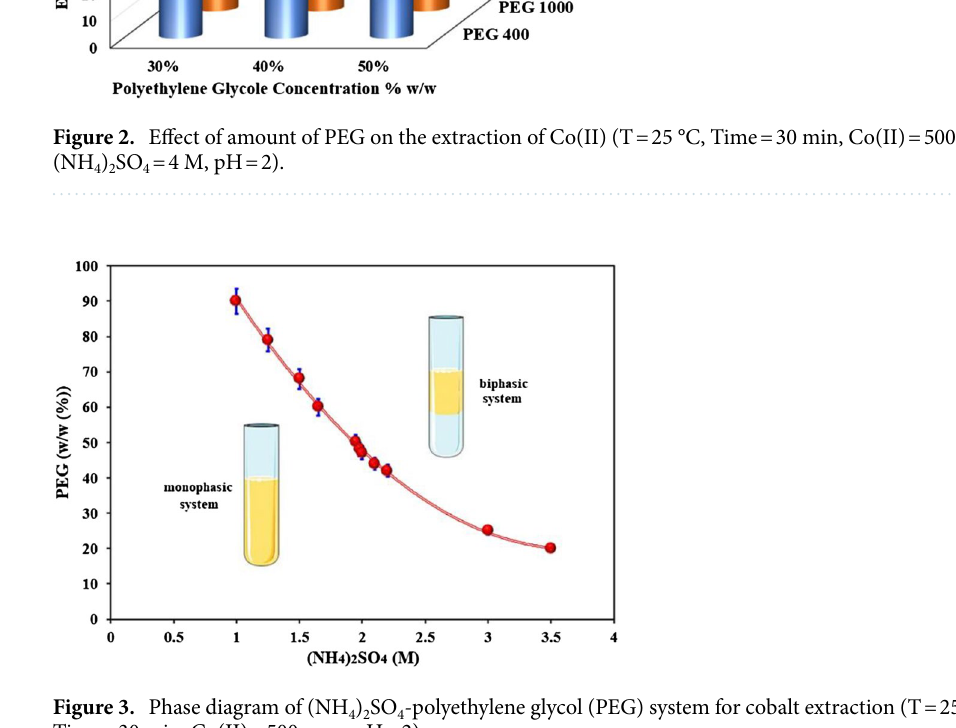
Figure 3. Phase diagram of (NH 4 ) 2 SO 4 -polyethylene glycol (PEG) system for cobalt extraction (T = 25 °C, Time = 30 min, Co(II) = 500 ppm, pH =